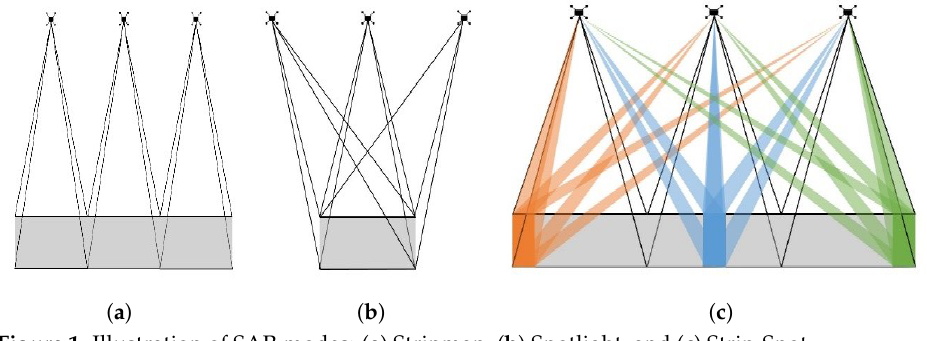
Figure 1. Illustration of SAR modes: ( a ) Stripmap, ( b ) Spotlight, and ( c )